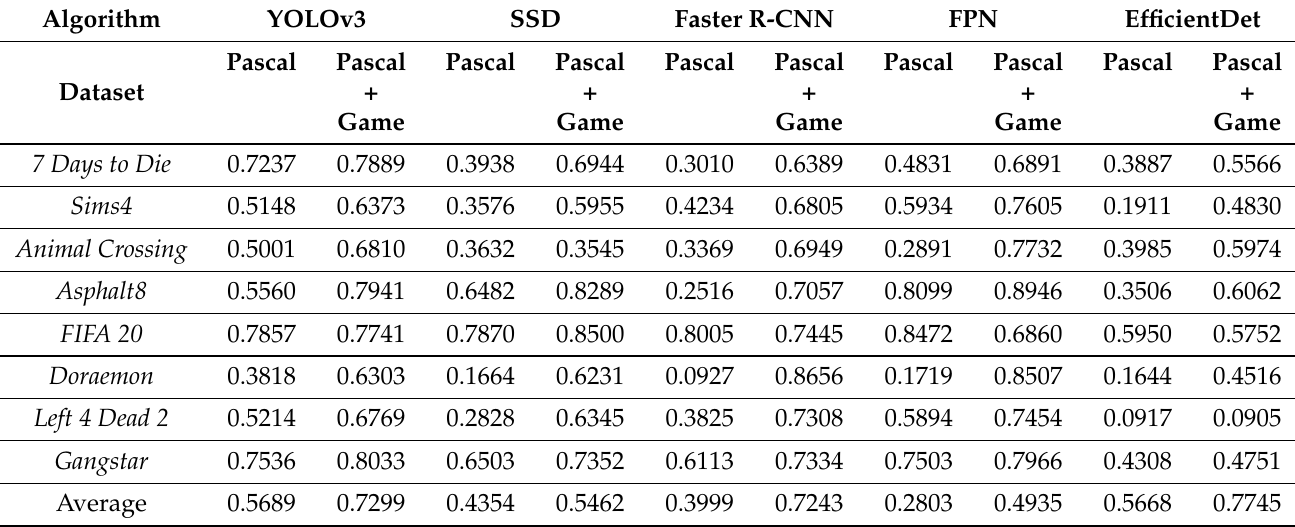
Table 4. The comparison of IoUs for each game. We compared five object detection algorithms pre-trained by PascalVOC and retrained by PascalVOC with game scenes. Note that PascalVOC is abbreviated as Pascal in the table. Algorithm